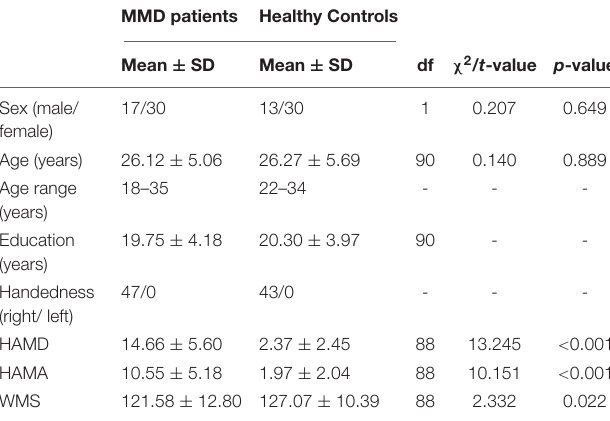
signal of each individual subject’s seed was set as an